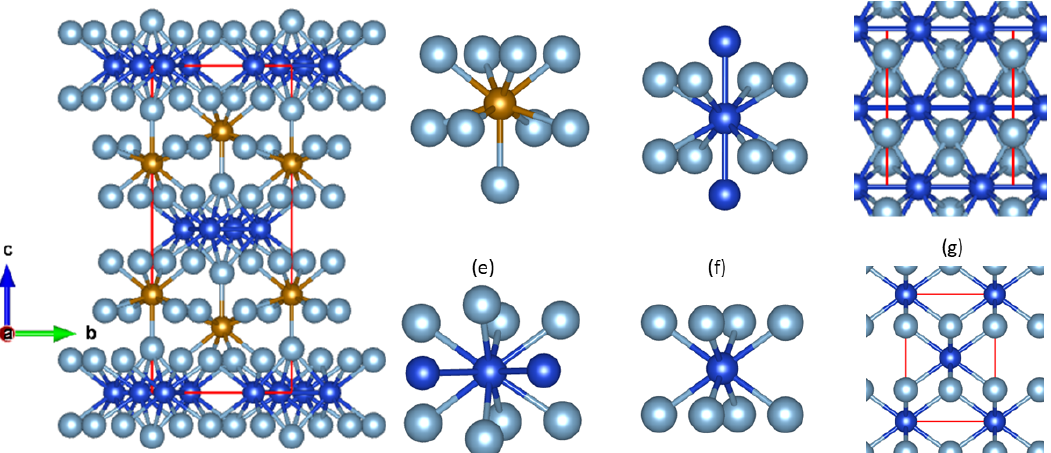
Figure 2. (Color on line) Schematic structure of ω -Al 7 Cu 2 Fe along its [100] direction ( a ) and related coordination of Fe ( b ) and Cu ( e ); of θ -Al 2 Cu ( d ) and the coordination of Cu ( c ); and of θ′ -Al 2 Cu ( g ) and the coordination of Cu ( f ). The silvery spheres represent Al, the blue spheres represent Cu, and the goldish spheres represent Fe.